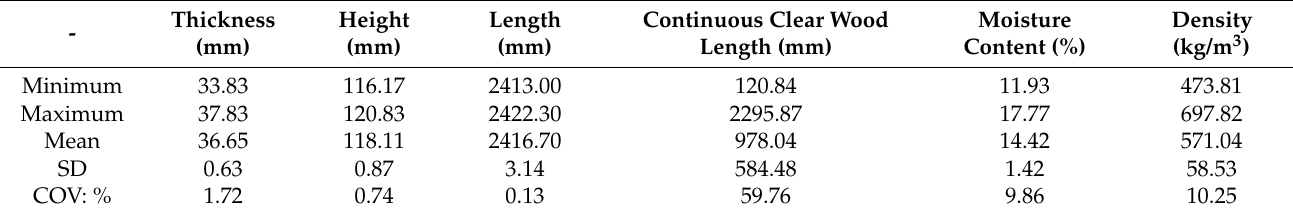
Table 1. Dimensions, visual characteristics, and physical properties of timber